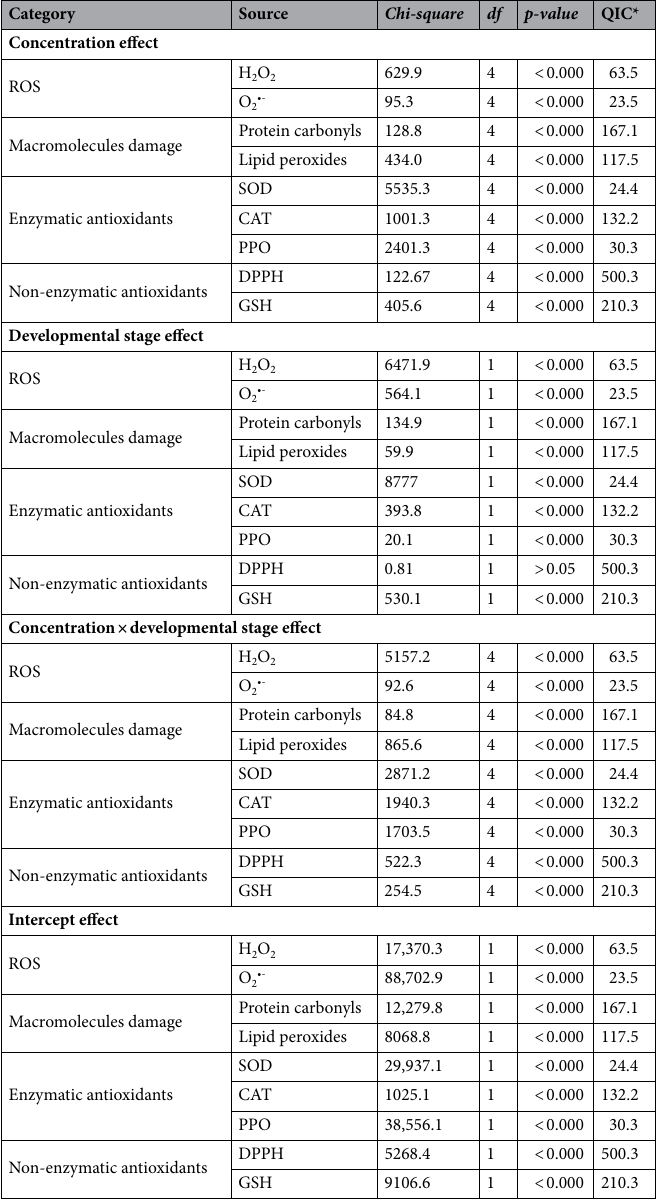
Table 3. Generalized Estimating Equation to analyze the malathion concentration (0, 0.005, 0.01, 0.015, and 0.002 mg/ml), insect developmental stage (5th larval instar and adult males), combined effect of malathion concentration with insect developmental stage and finally intercept on reactive oxygen species concentration (ROS), (inform of hydrogen peroxide (H 2 O 2 ), superoxide anion radical (O 2•- )), macromolecules damage (inform of protein carbonyls amount and lipid peroxides concentration), enzymatic antioxidant response (inform of superoxide dismutase (SOD), catalase (CAT), and polyphenol oxidase (PPO)), and finally non- enzymatic antioxidant response (inform of anti-radical 2,2-diphenyl-1-picrylhydrazyl (DPPH) and antioxidant glutathione reduced (GSH)) in the gut homogenates of 5 th instar larvae and adult males of Hermetia illucens. * Quasi Like hood under Independence Model